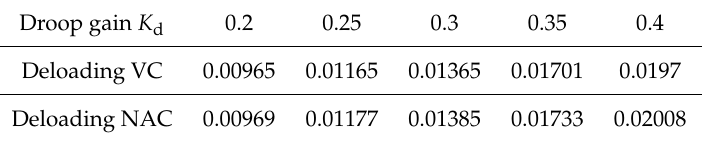
Table 3. Overall control costs of different control schemes with varying de-loading droop